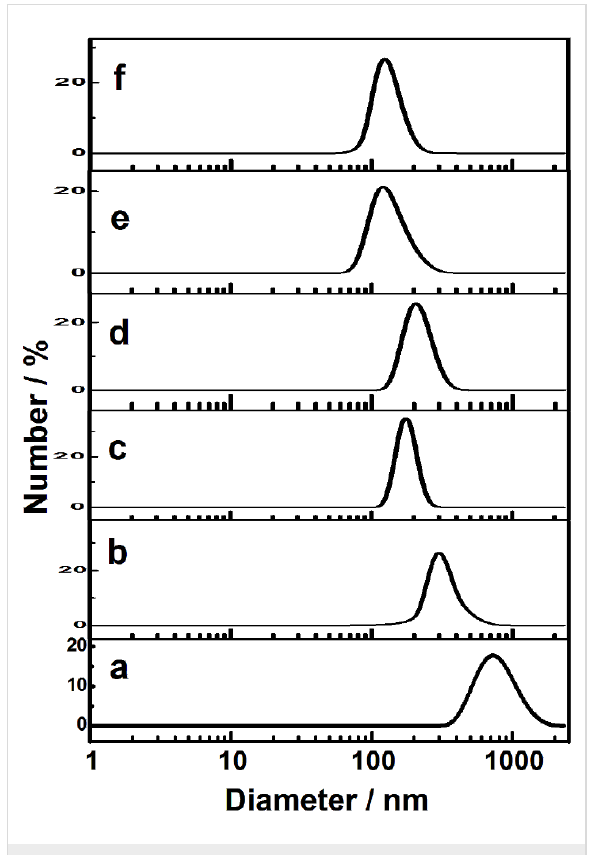
Figure 3: Analysis of the size distribution of 2c (a), 2d (b), 2e (c), 2f (d), 2g (e), 2h (f) particles in water/DMF (50% v/v) solutions using the number parameter, c = 1 mM, 25